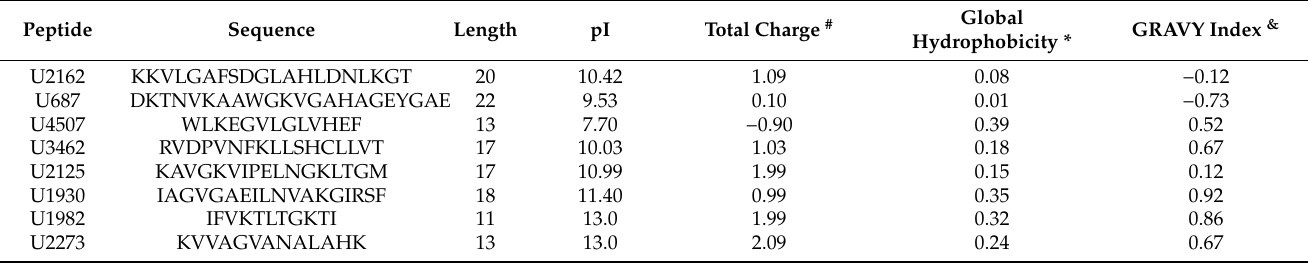
Table 7. The resulting eight ABP candidates from the virtual human urine peptidome screening and some of its global sequence descriptors. Global peptide descriptors were calculated using the Peptide Design and Analysis Under Galaxy (PDAUG) package